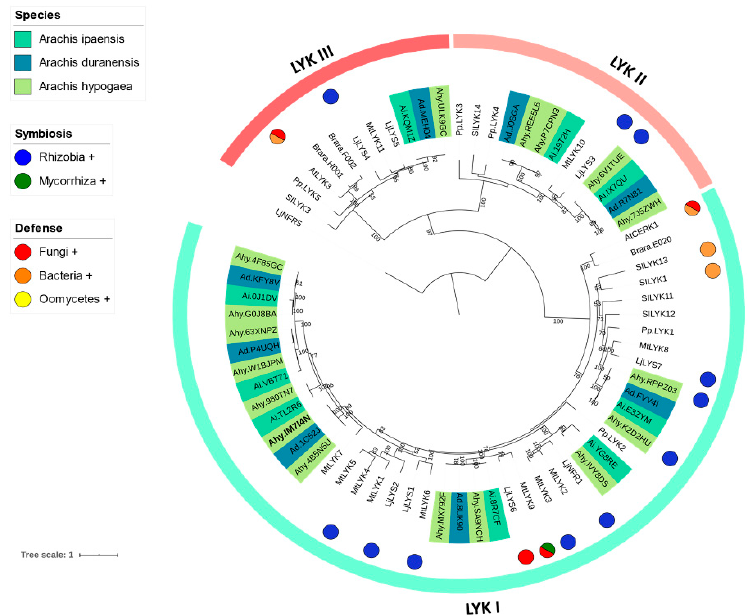
Figure 1. ML phylogenetic tree of LYKs. Different phylogenetic groups are shown. One LYR protein (LjNFR5) was used as an outgroup sequence. The best model fitting the alignment was JTT+I+G+F, gama = 1.616, p-inv = 0.018. Participation of the receptors in rhizobial or mycorrhizal symbioses and defense against bacteria, fungi or oomycetes is indicated using the symbol code. The tree was drawn using iTol.